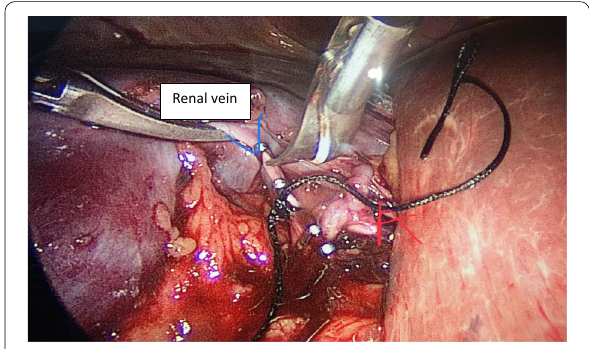
Fig. 1 Identification of the renal pedicle, clamping and cutting using laparoscopic